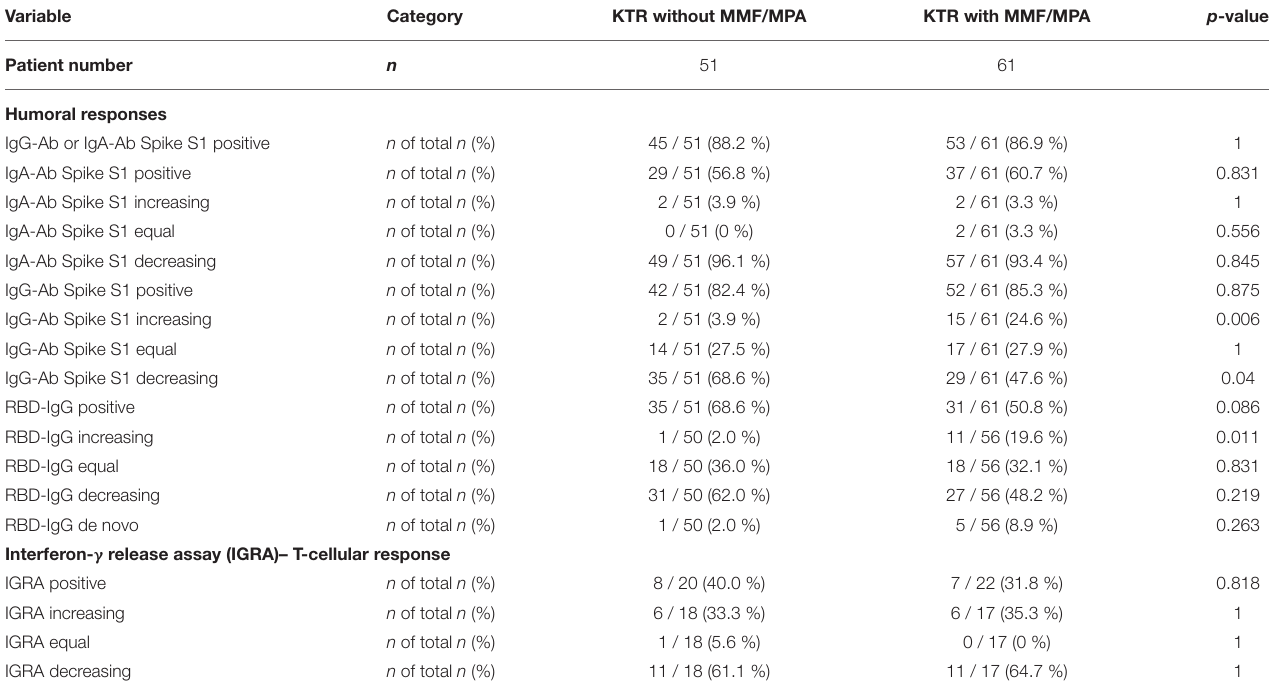
TABLE 1 | Immune response rates 6 months after vaccination (T3) compared to T2 in the seroconverted Kidney transplant recipients (KTR) 112 cohort. Variable Category